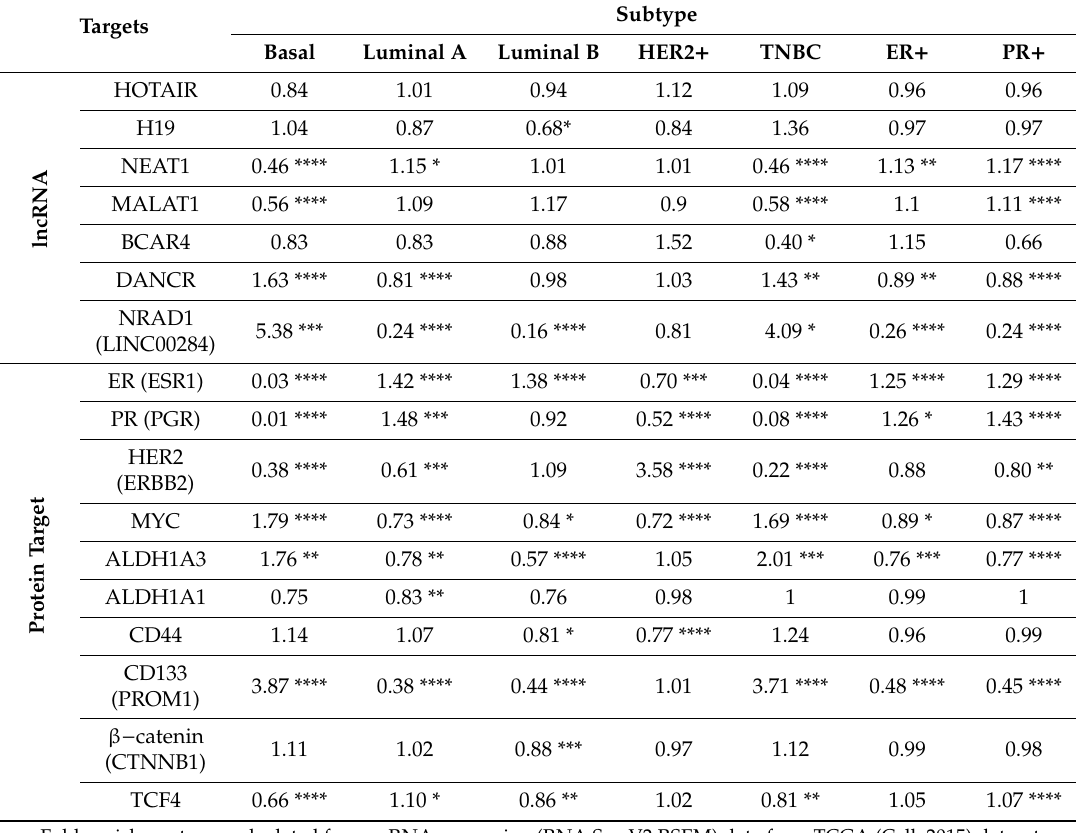
Table 3. LncRNA and protein target fold-enrichment by breast cancer subtype.